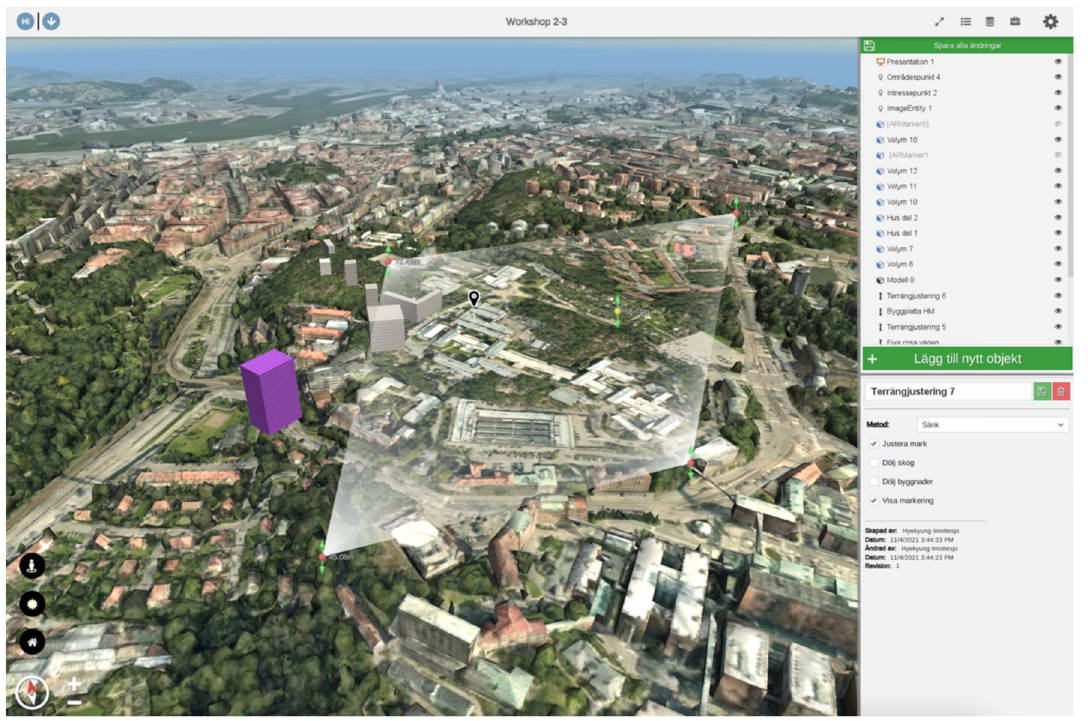
Figure 9. The terrain adjustment function, allowing users to change the terrain, including build- ings.The information text for terrain adjustment has four check boxes: (from the top) Adjust terrain, Hide forest, Hide buildings, Show markings.